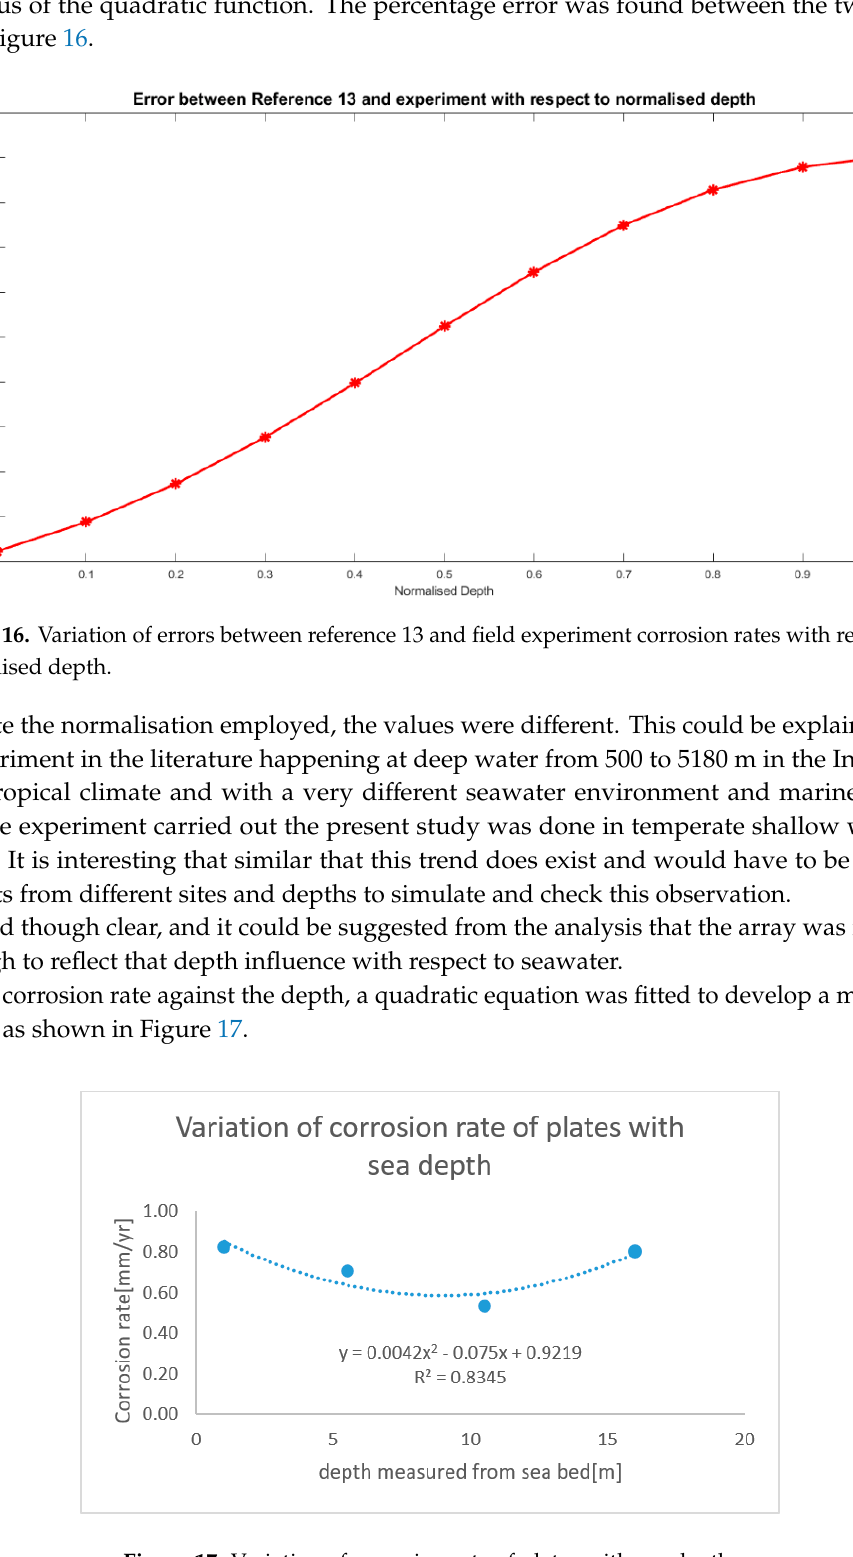
Figure 17. Variation of corrosion rate of plates with sea depth.